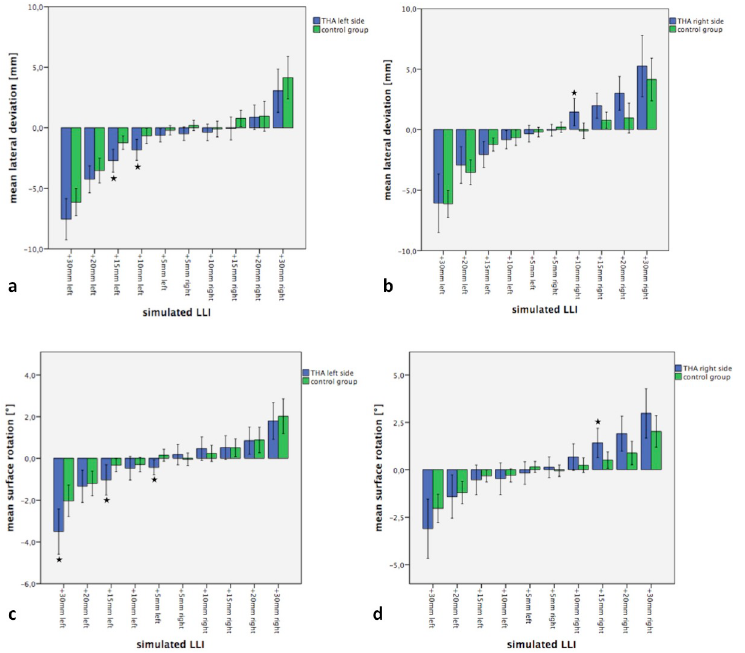
Fig 3. Effects of simulated LLIs on pelvic position of patients with and without THA. a) Changes of pelvic obliquity. Imaged for patients after THA of the left side (blue bar columns) and control group of healthy subjects (green bar columns). LLIs were simulated on the operated left side and the non-operated right side. b) Results for patients after THA of the right side with corresponding control group. LLIs were simulated on the leg of the THA and the contralateral leg. c) Changes of pelvic torsion in patients after THA of the left side and the control group of healthy subjects. LLIs were simulated on the operated left side and the contralateral side. d) Results for patients after THA of the right side with corresponding control group. LLIs were simulated on the leg of the THA and the contralateral leg. Significant differences (p < 0.05) are marked with a star.